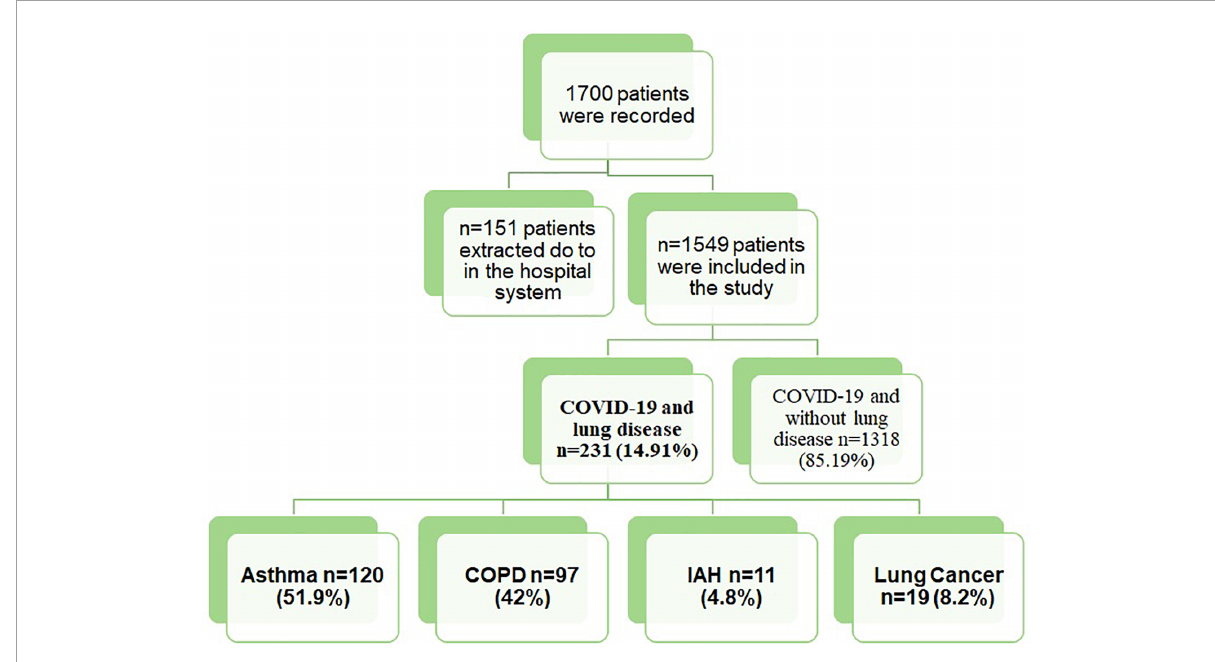
FIGURE1 A flow chart of patient recruitment. Abbreviations: COPD, chronic obstructive lung disease; ILD, interstitial lung disease.